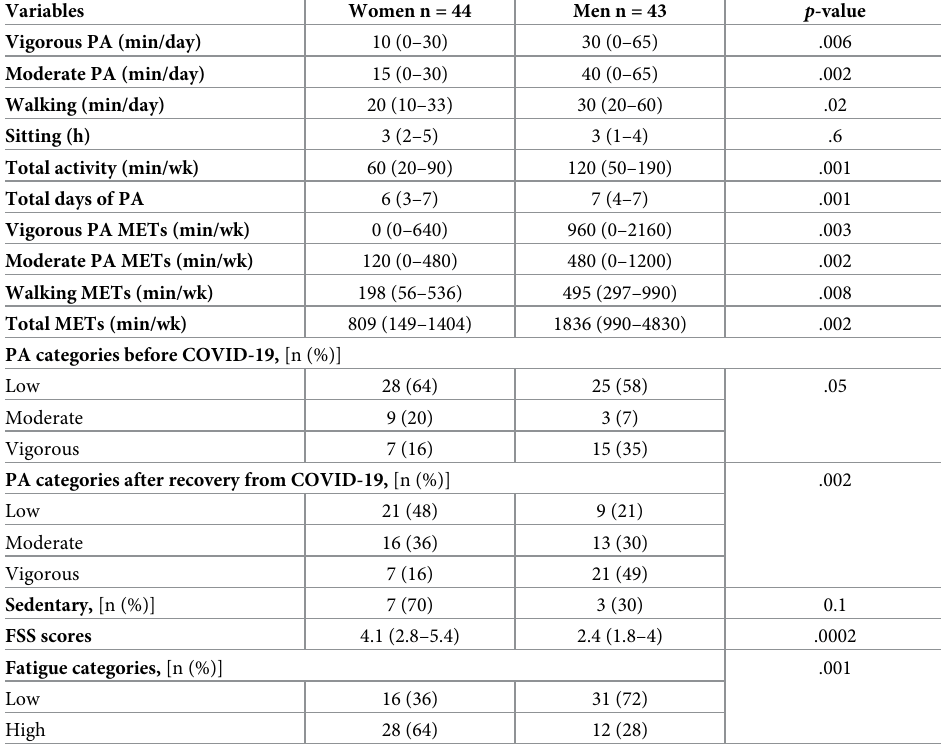
Table 3. Gender-based comparison of physical activity levels and fatigue severity.